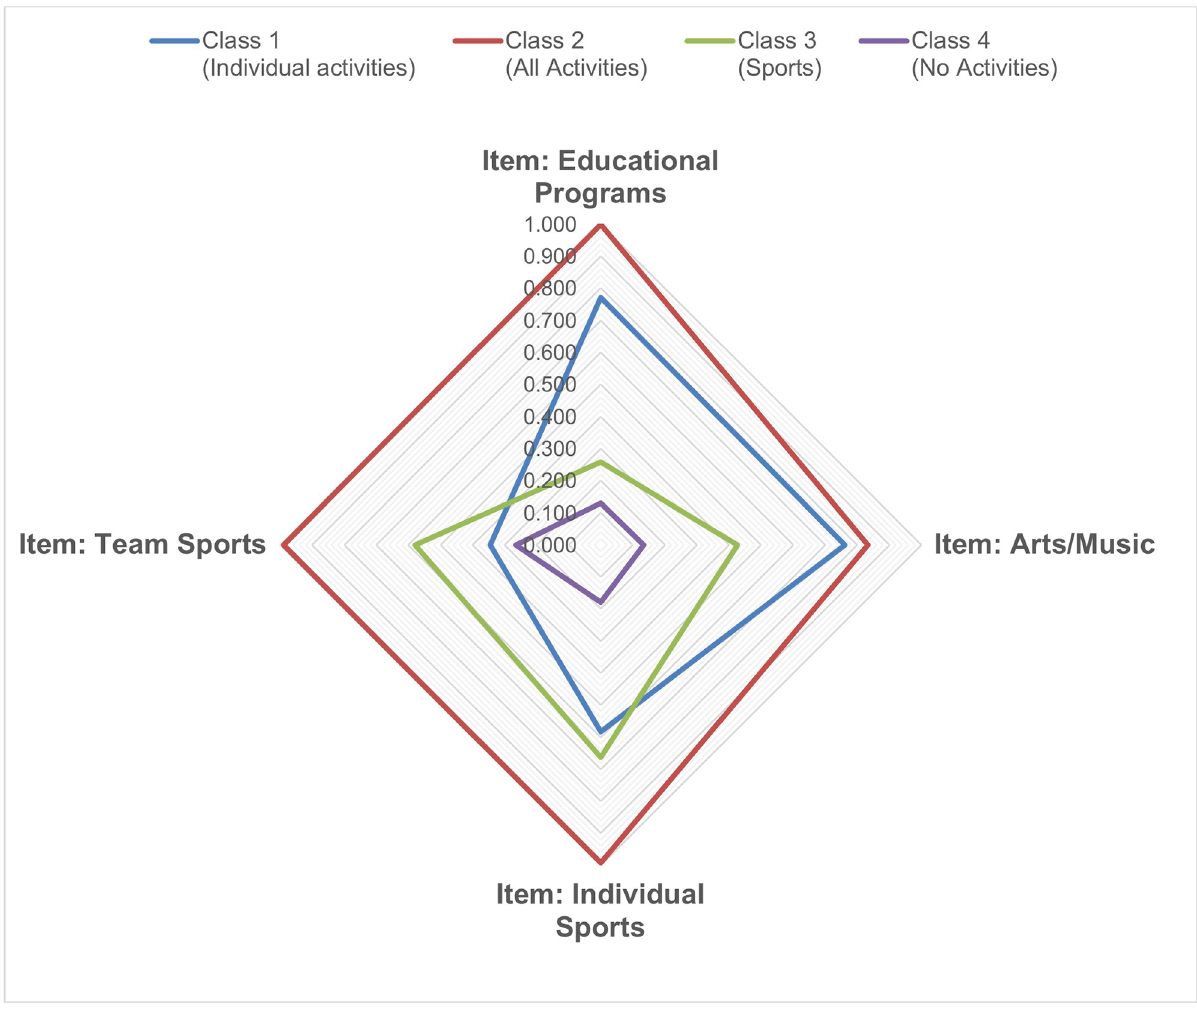
Fig 1. Extracurricular activities